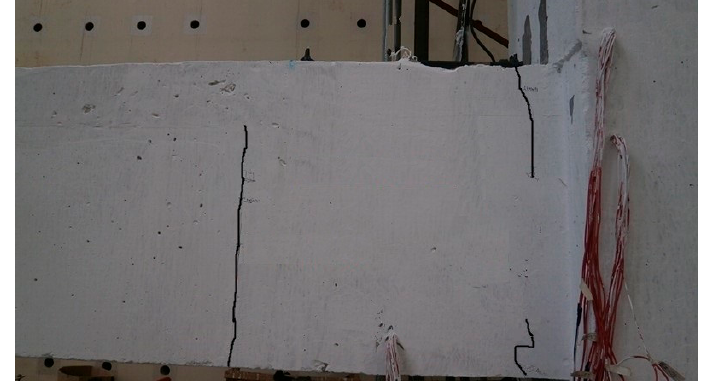
Figure 13. The initial cracking of PPCJ2 joint.